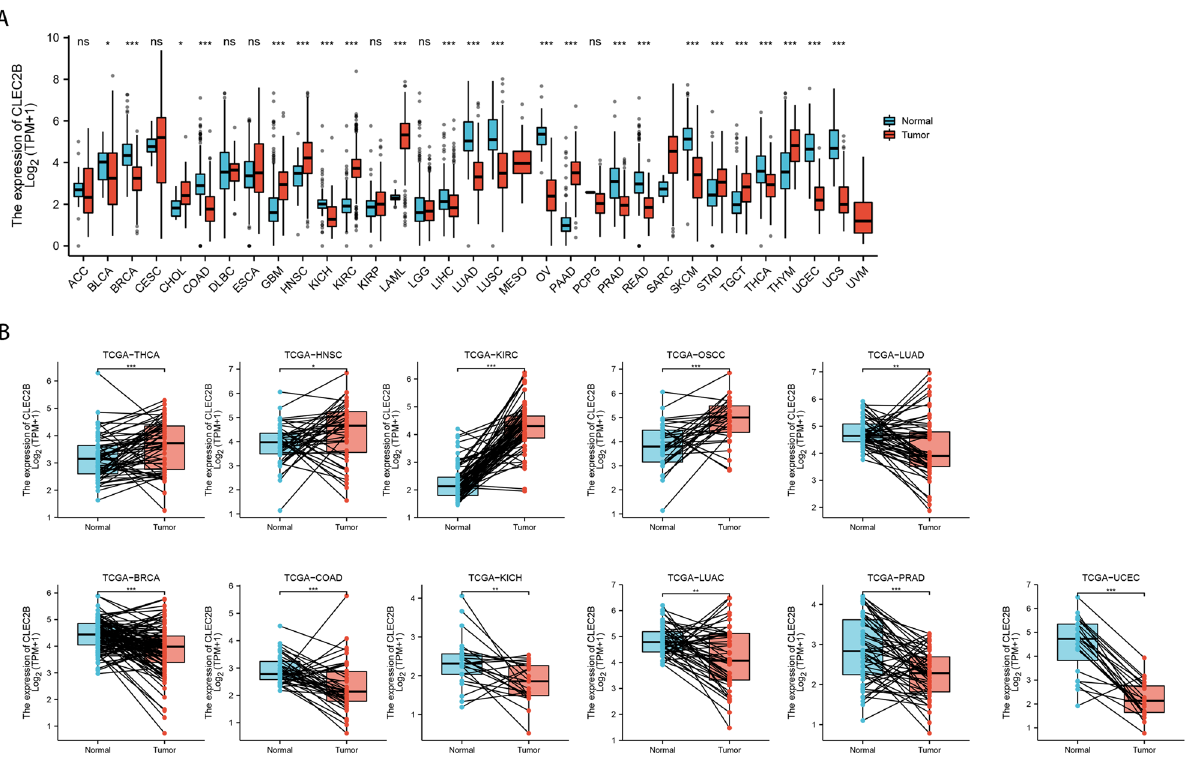
Figure 7. CLEC2B expression analysis in pan-cancer. ( A ) Unpaired expression differences of CLEC2B in pan- cancer from TCGA + GTEx; ( B ) expression differences of CLEC2B in paired tumor and normal tissues in TCGA pan-cancer.